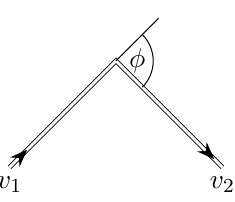
Figure 1 . Wilson line with two straight line segments forming a cusp with Euclidean cusp angle (cid:30)